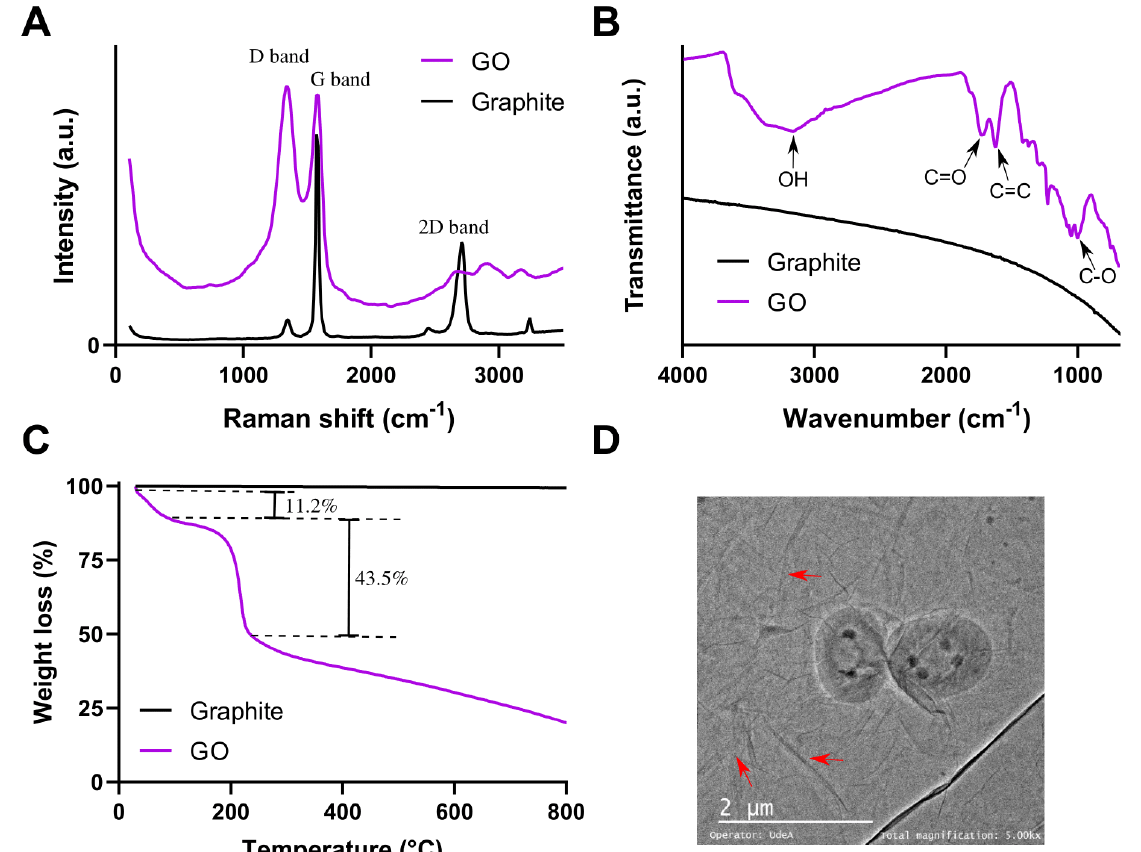
Figure 2. ( A ) Raman spectra of GO and graphite. ( B ) FTIR spectra of GO and graphite. ( C ) TGA of GO and graphite. ( D ) TEM image of GO flakes: red arrows point to folds on GO flakes.